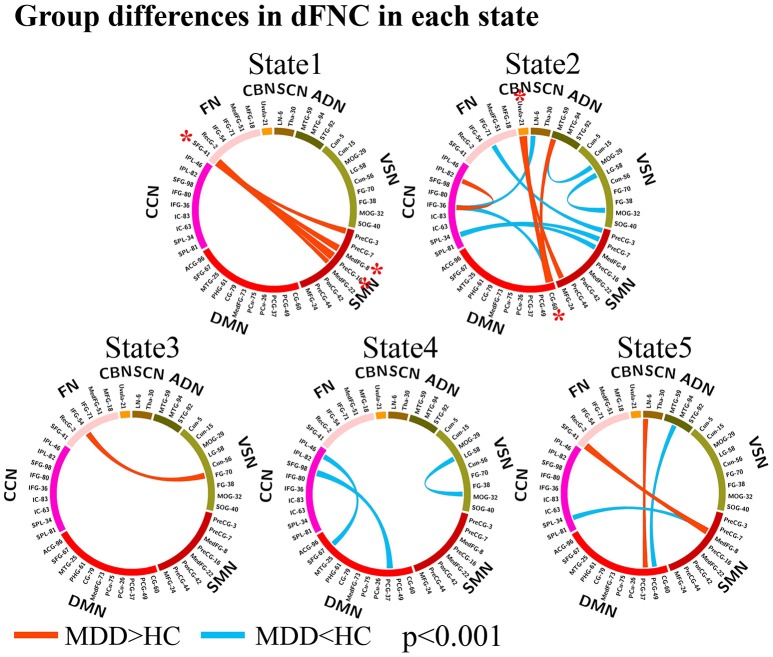
Group differences in dFNC in each state (p < 0.001, uncorrected). The wider line means larger group difference. Red lines represent increased connectivity while blue lines represent decreased connectivity in MDD patients. The red asterisks indicate significant group differences (FDR corrected).